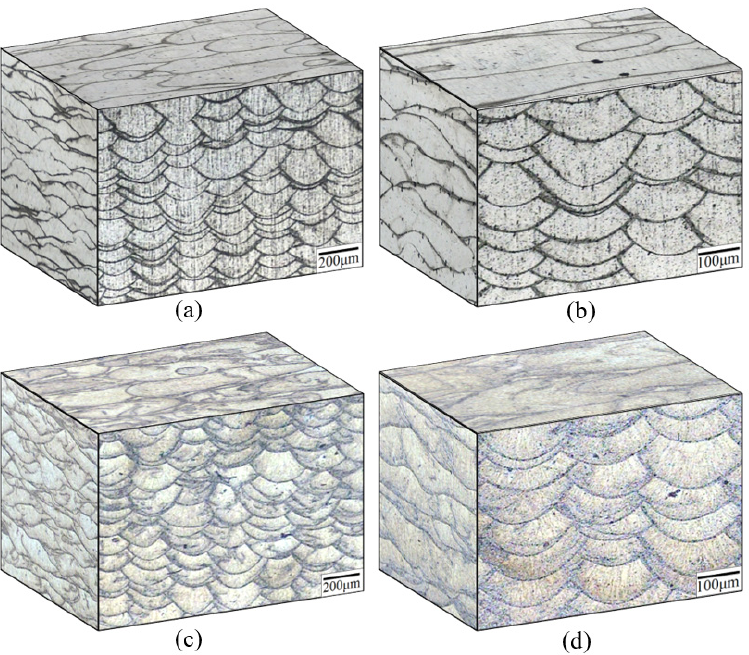
Figure 3. Three-dimensional microstructure of the Al-Ni-Cu alloy: ( a ) As-printed (50 × ), ( b ) As-printed (100 × ), ( c ) 530 ◦ C for 1 h and 175 ◦ C for 6 h (50 × ), and ( d ) 530 ◦ C for 1 h and 175 ◦ C for 6 h (100 × ).